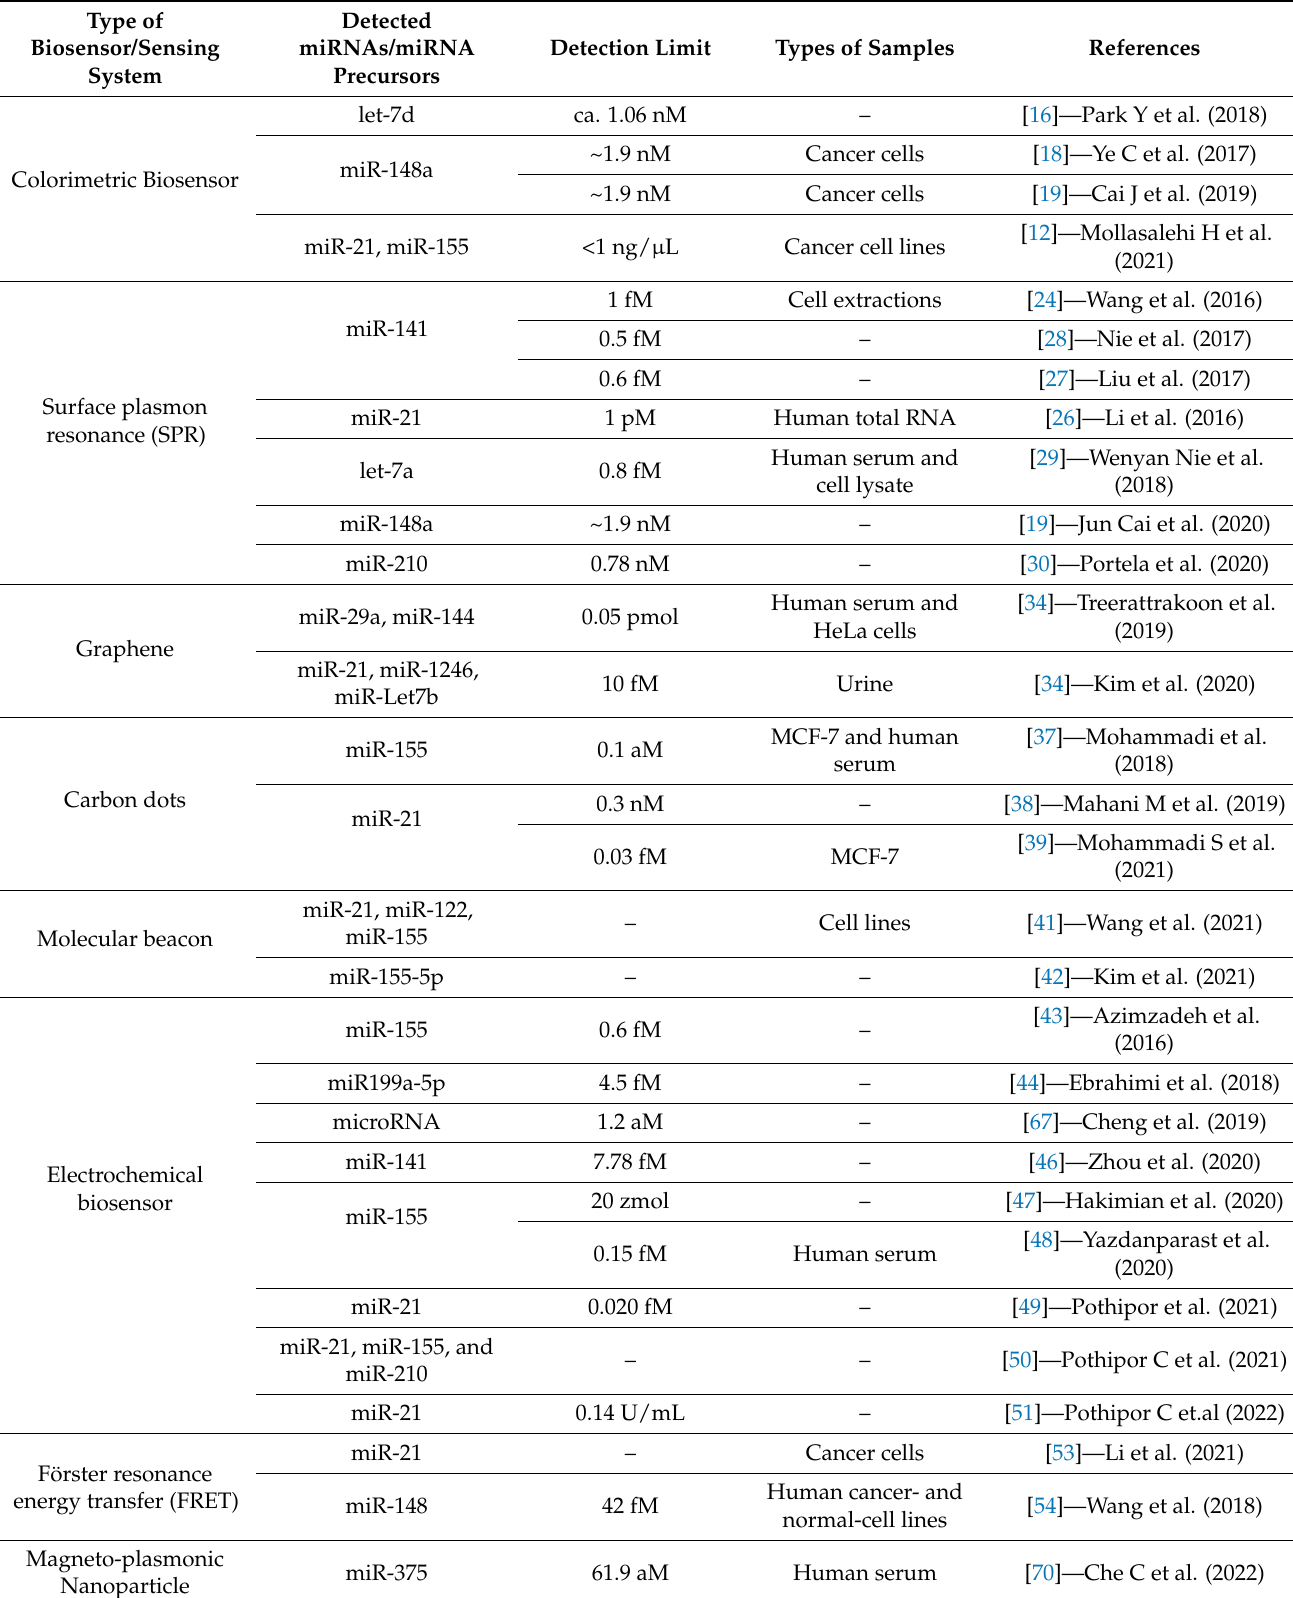
Table 1. miRNAs for